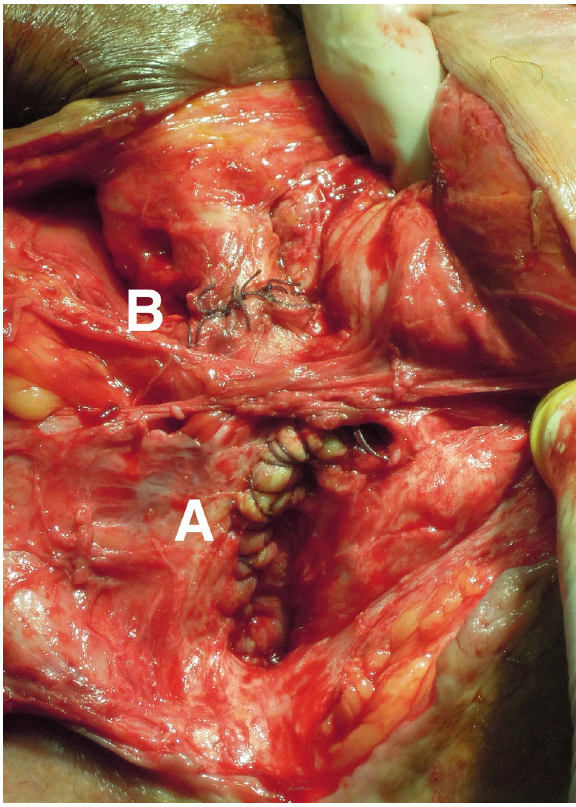
Figure 5: A: Sutured urethra after excision of the diverticulum; B: End-to-end anastomosis after excision stricture of the urethra distal to the